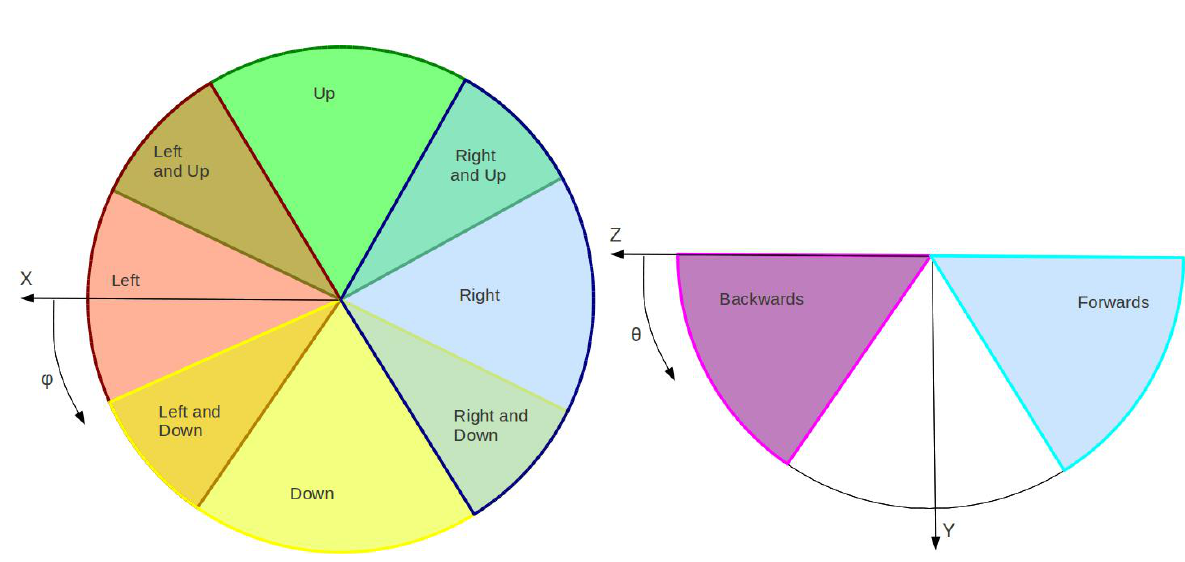
Figure 9. Dynamic hand gestures